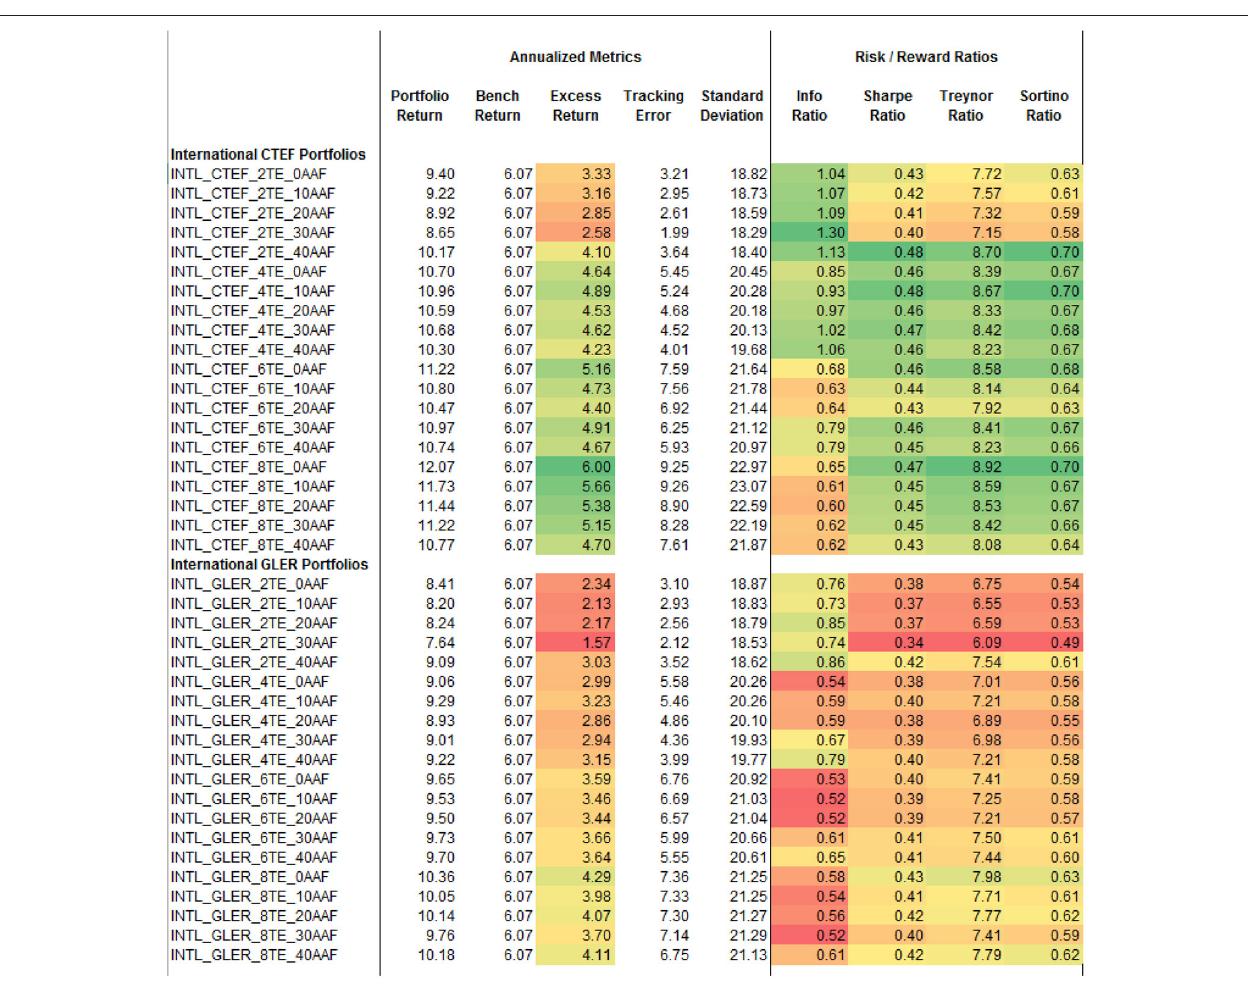
FIGURE 2 | International